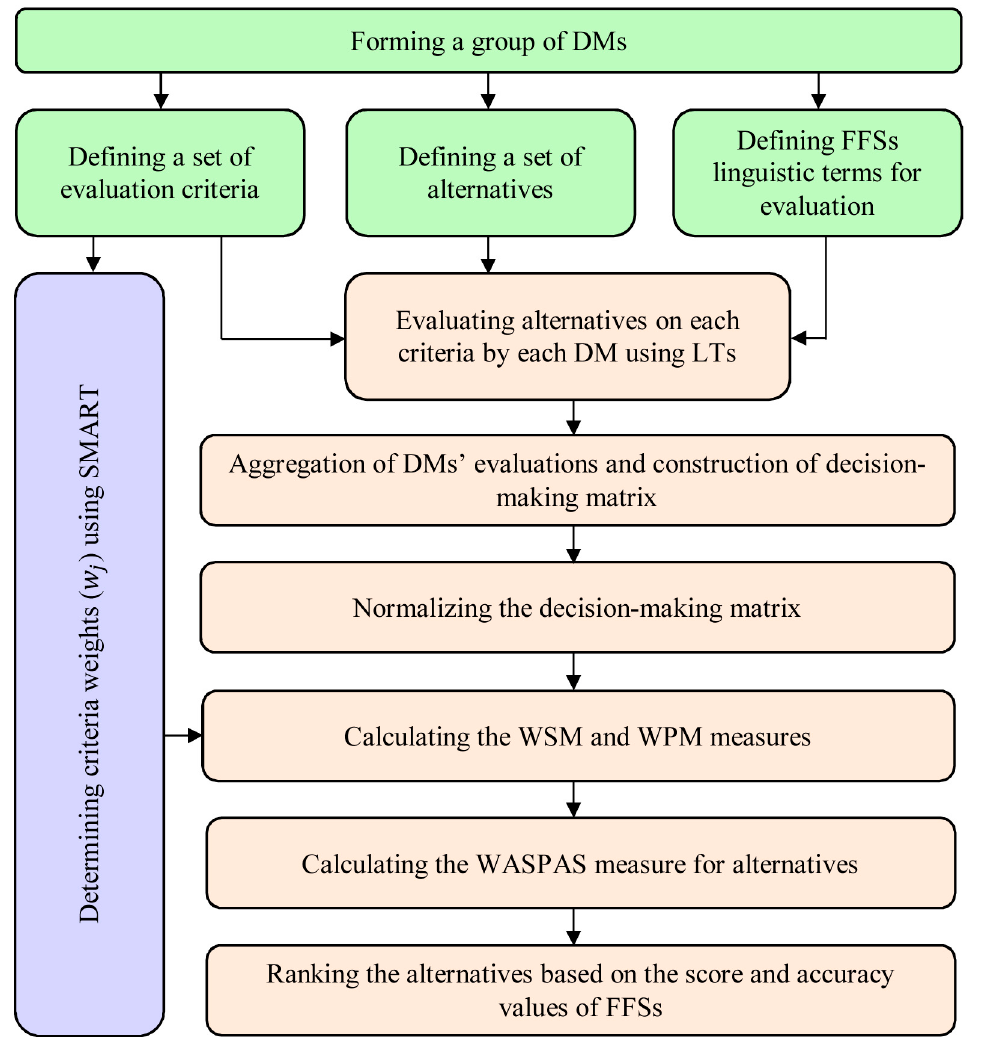
Figure 5. The framework of using Fermatean fuzzy WASPAS.